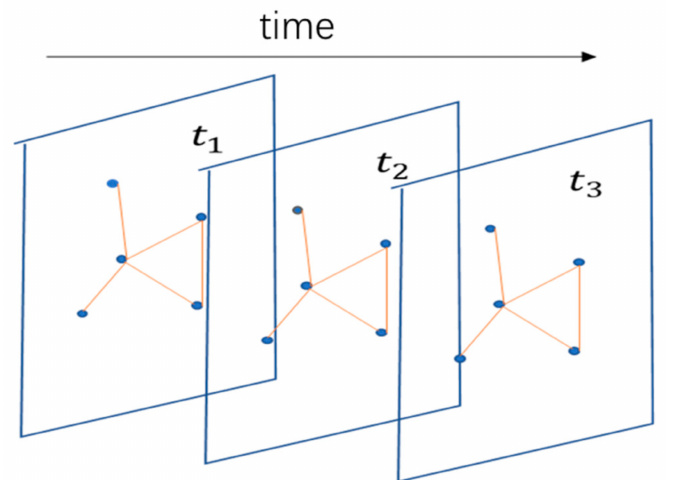
Figure 1. The spatial-temporal structure of traffic data, where the data at each time slice form a